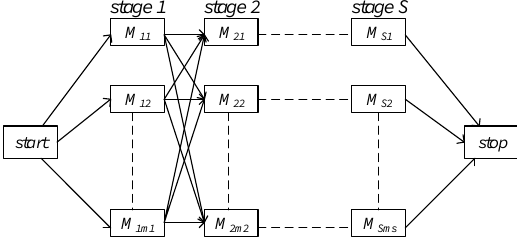
Figure 1. Flow chart of a typical HFSP.